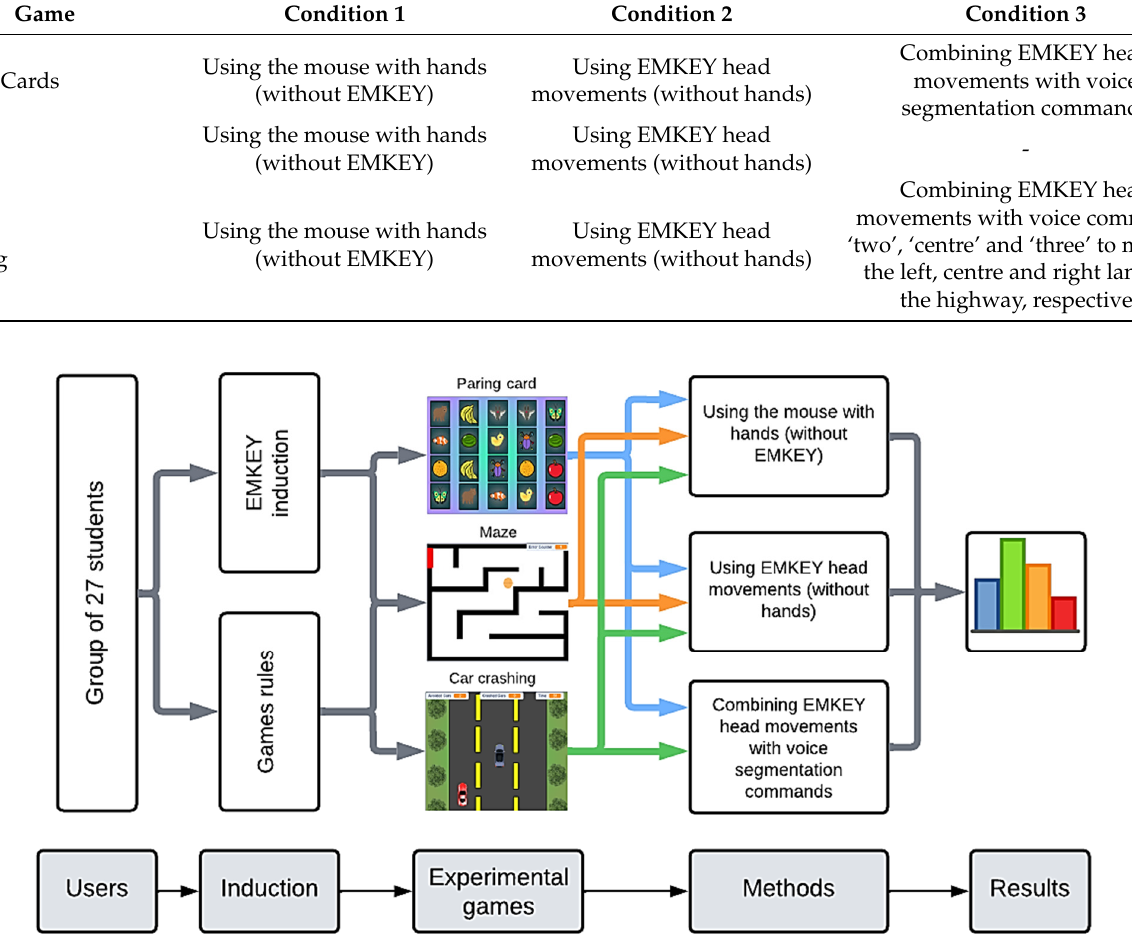
Figure 6. Process that the participants underwent.